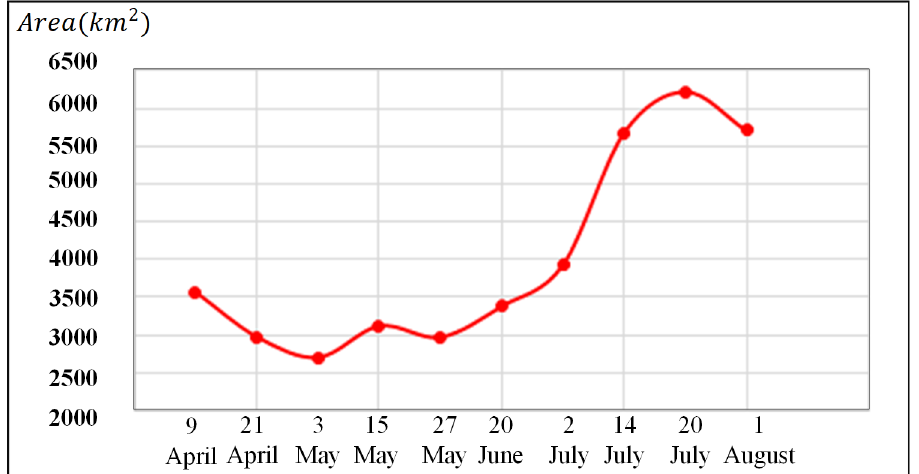
Figure 16. Statistical results of the water area of Poyang Lake from the pre-flood period to the flood period in 2020.